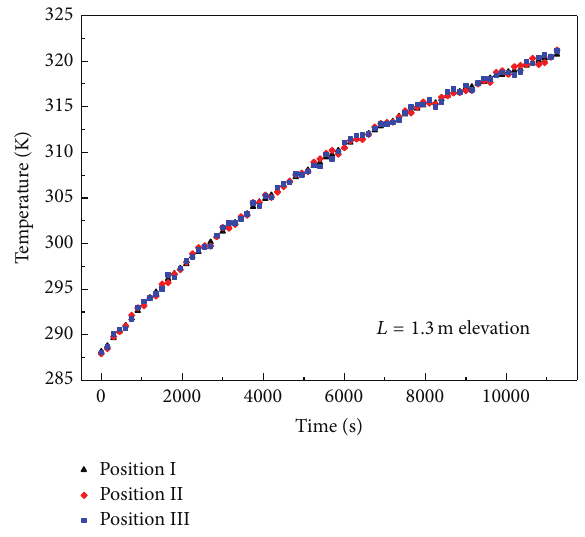
Figure5:Comparisonoftankfluidtemperatureatdifferentposition as a function of time.